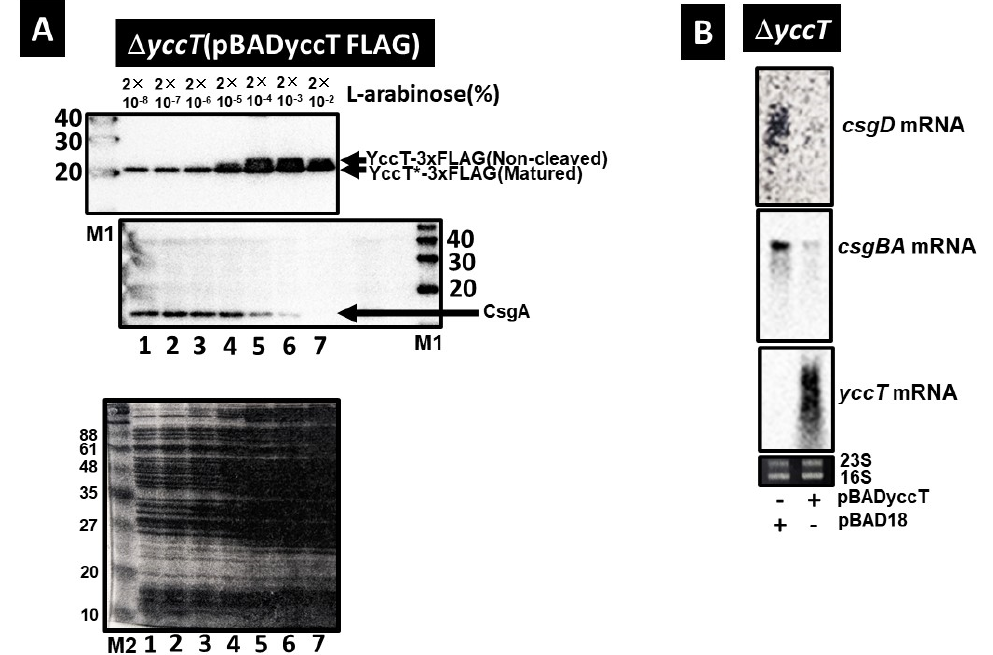
Figure 5. Effects of YccT overexpression on the expression of curli synthesis genes. ( A ) Full-length YccT-FLAG (non-cleaved), YccT*-FLAG (mature YccT-FLAG with cleaved signal peptide), and CsgA expression in the BWDyccT strain (with yccT deletion) transformed with pBADyccT-FLAG in the presence of several concentrations of L-arabinose (from 2 × 10 − 9 to 2 × 10 − 3 %). Anti-FLAG tag and anti-CsgA peptide antibodies were used for the detection of YccT-FLAG and CsgA by Western blot. SDS PAGE was carried out for comparison of total proteins in the cells among each strain (lower panel). ( B ) The expression of csgD (upper panel), csgB (middle panel), and yccT (lower panel) mRNAs in the BWDyccT strain transformed with the control vector pBAD18 ( − ) or pBADyccT (YccT) in the presence of 2 × 10 − 2 % L-arabinose was detected via Northern blot. All of csgD , csgB and yccT mRNA were detected with DIG ‐ labelled csgD , csgB or yccT 3 ′ probes (see Section 4). The 23S and 16S rRNA were detected by ethidium bromide staining.